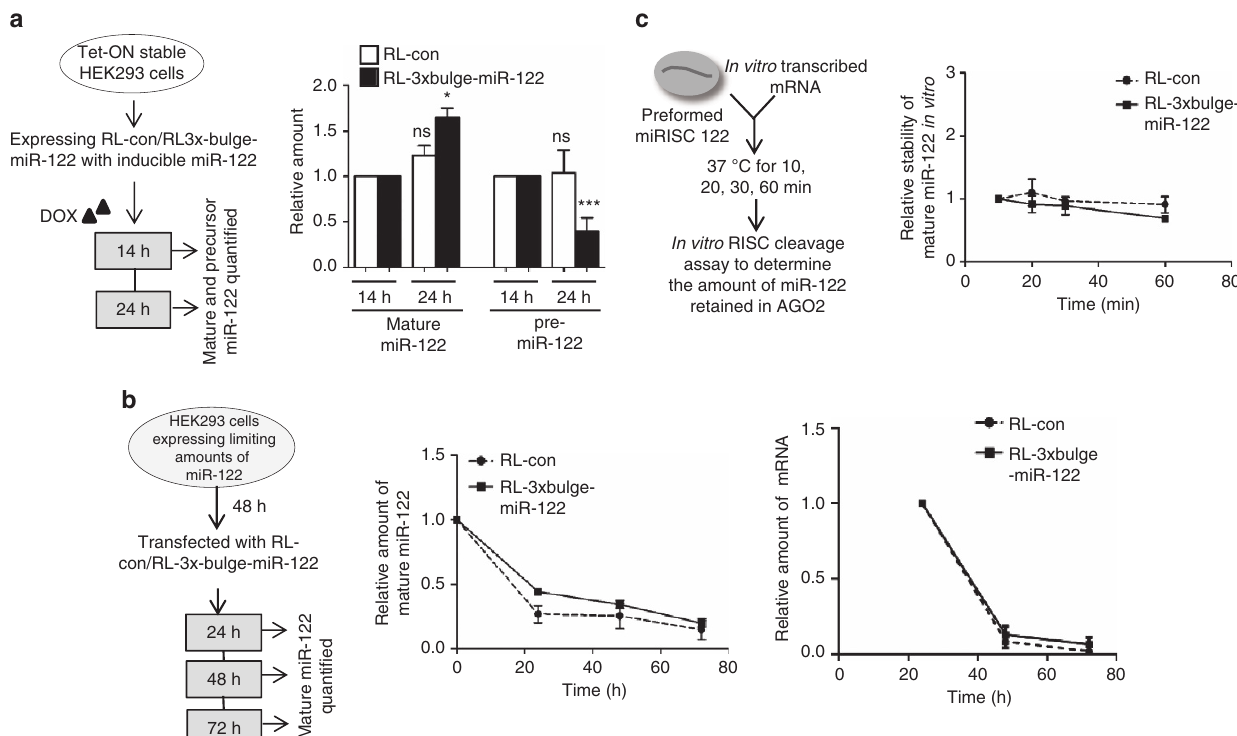
Figure 4 | Target mRNA drives increased biogenesis of mature miRNA from pre-miRNA. ( a ) De novo synthesis of mature miR-122 in the presence of target mRNA is accompanied by a simultaneous drop in pre-miR-122 level. Experimental format is illustrated in the left panel. Tet-ON HEK293 cells were induced for specific time points with doxycycline to synthesize pre-miR-122 from a plasmid with Tet-response element. Cells were harvested after 14 and 24h, and mature and pre-miR-122 levels quantified. To measure the relative changes at 24h, values at 14h are taken as the unit. ( b ) Target mRNA-induced increase of miRNA levels does not occur due to enhanced stability of a preformed miRNP in the presence of target mRNA. Cells were transfected with 1 m M synthetic pre-miR-122. After 48h, cells were again transfected with RL-con or RL-3 (cid:2) bulge-miR-122 plasmids. This was followed by RNA isolation after 24, 48 and 72h, and mature miR-122 levels quantified to plot the decay rate of mature miR-122. Relative changes in levels of target RNAs over time have been plotted. ( c ) FH-AGO2 was immunoprecipitated from FH-AGO2-stable HEK293 cells transfected with pre-miR-122 plasmid and FH-AGO2 beads corresponding to B 2 (cid:2) 10 6 cells were incubated with 500ng in vitro -transcribed RL-con or RL-3 (cid:2) bulge-miR-122 mRNA in a 20 m l reaction for increasing time. The supernatant was removed and on-bead RISC cleavage assay was subsequently performed to quantify the amount of miR-122 retained with AGO2 post interaction with target mRNA. Paired two-tailed Student’s t -tests were used for all comparisons. * P o 0.05, ** P o 0.01 and *** P o 0.001. Values plotted are means from at least three biological replicates for a and two for b and c . Error bars represent